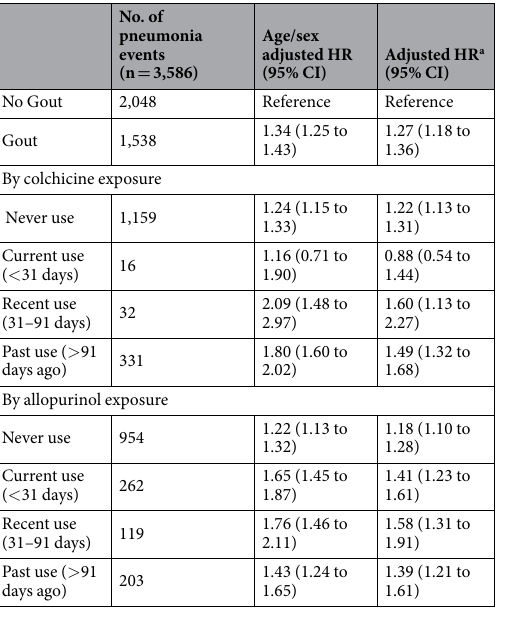
Table 2. Risk of pneumonia in patients with gout compared to matched controls, stratified by use of colchicine and allopurinol. Abbreviations: HR: indicates hazards ratio; CI, confidence interval; PY, person years. (a) Adjusted for age, sex, body mass index, smoking status, alcohol use, the most recently recorded estimated glomerular filtration rate in the past year, a history of dementia, dysphagia, and the use of bronchodilators, inhalation corticosteroids, systemic corticosteroids, non-insulin anti-diabetic drugs, insulin within 6 months before, the use of influenza vaccinations 1 year before and the use of pneumococcal vaccinations 5 years before.